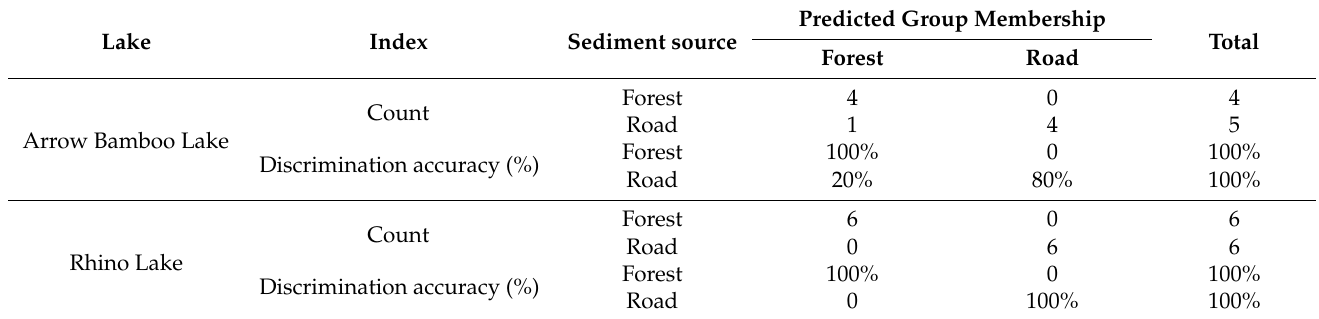
Table 3. Discriminant results of the composite fingerprints at Arrow Bamboo and Rhino Lakes.